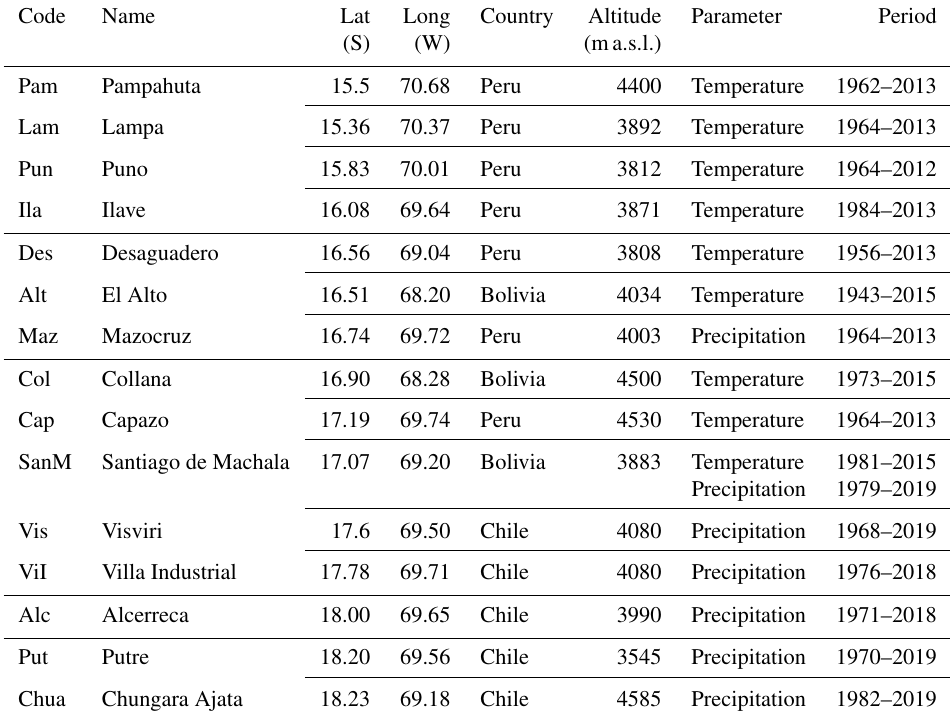
Table 2. Geographical locations of the meteorological stations in the Altiplano used in this study to compose the regional precipitation and temperature indexes for the northern